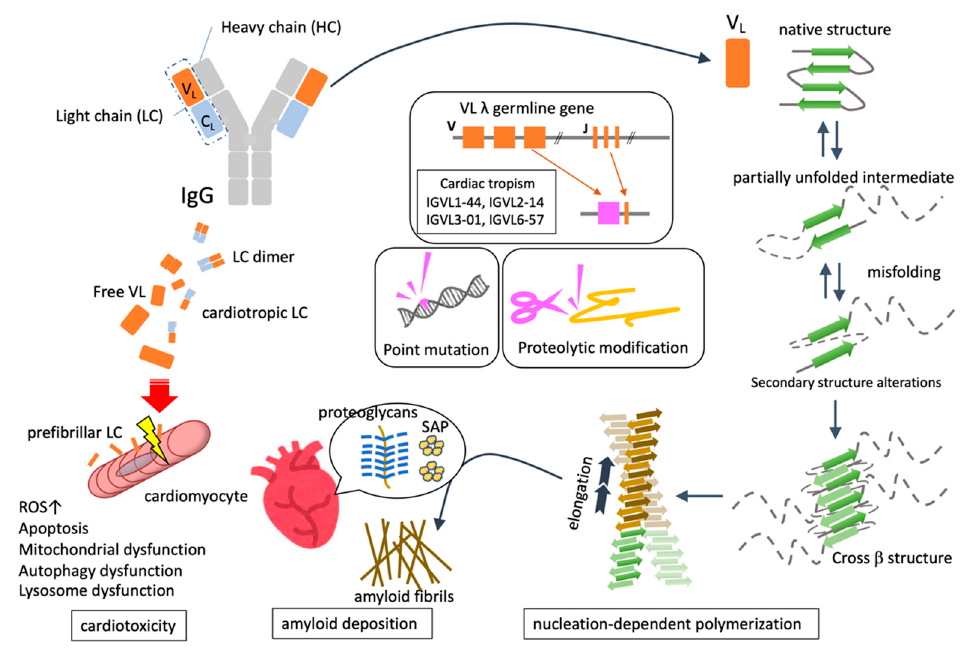
Figure 1. Molecular mechanisms of cardiotoxicity in AL amyloidosis.